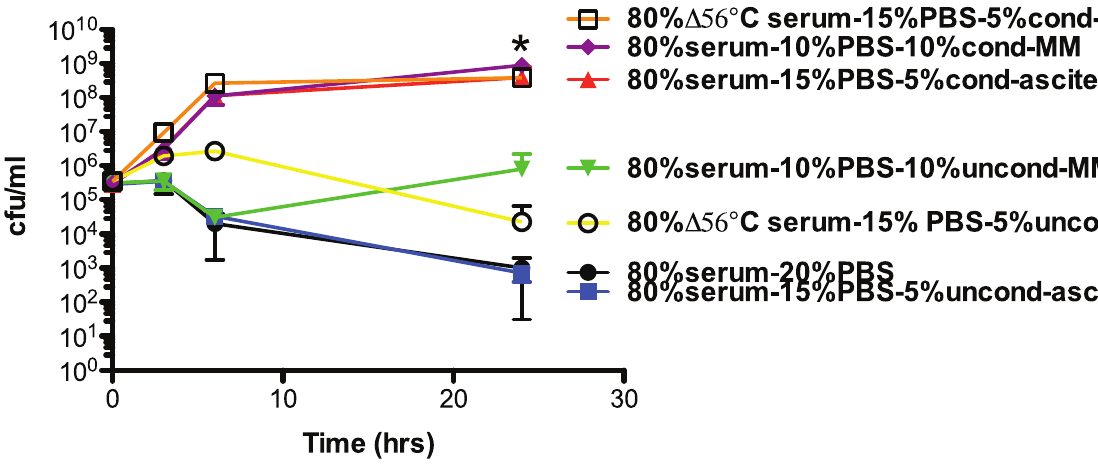
Figure 4. The survival of hvKP1 in 80% human serum is significantly increased when serum is supplemented with hvKP1 generated conditioned ascites or minimal medium. The survival of hvKP1 in 80% active or heat inactivated (56 u C for 30 minutes ( D 56 u C)) human serum was assessed at 0, 3, 6, and 24 hours. Growth in heat inactivated serum served was a positive control that established that decreased survival was due to complement-mediated bactericidal activity. The active serum was supplemented with final concentrations of: 1) 20% 1 6 phosphate-buffered saline (PBS), 2) 15% PBS plus 5% unconditioned ascites (uncond-ascites; batch 2), 3) 10% PBS and 10% unconditioned M9 minimal medium (uncond-MM), 4) 15% PBS and 5% conditioned ascites (cond-ascites; batch 2), and 5) 10% PBS and 10% conditioned M9 minimal medium (cond-MM). The heat inactivated serum was supplemented with final concentrations of: 1) 15% PBS and 5% unconditioned ascites (uncond-ascites) and 2) 15% PBS and 5% conditioned ascites (cond-ascites). Survival of hvKP1 was significantly increased when 80% active serum was supplemented with hvKP1-conditioned ascites compared to unconditioned ascites (*P , 0.05/1) or when supplemented with conditioned M9 minimal medium compared to unconditioned M9 minimal medium (*P , 0.05/1). Survival of hvKP1 was significantly increased when 80% heat inactivated serum was supplemented with hvKP1- conditioned ascites compared to unconditioned ascites (*P , 0.05/1). Data are Mean 6 S.E.M.; N=3–4.